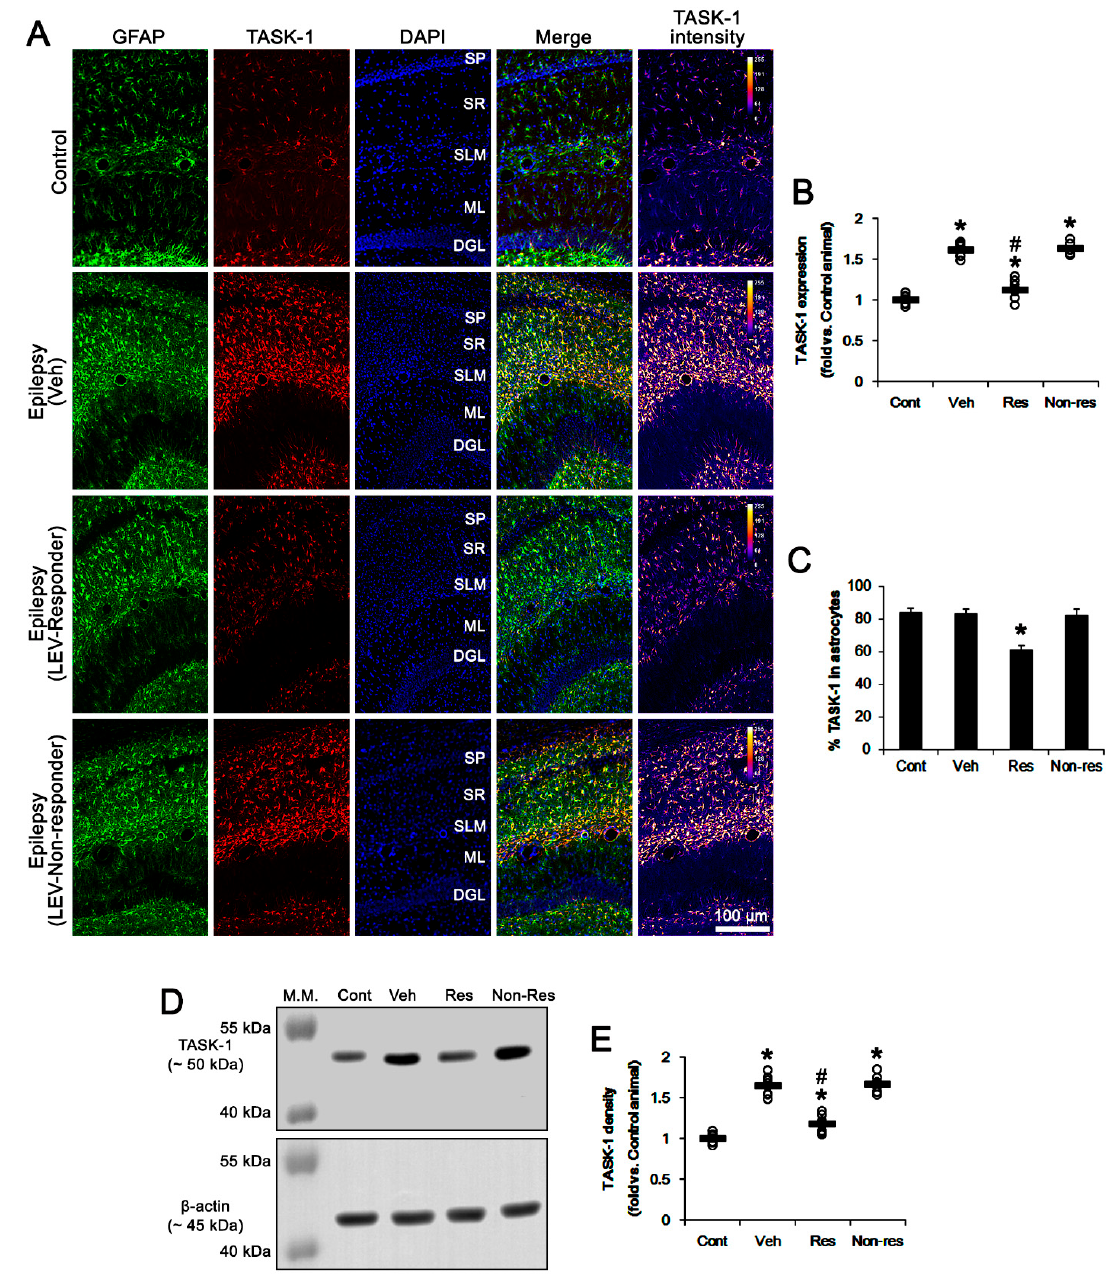
Figure 3. The effect of levetiracetam (LEV) on TASK-1 expression in chronically epileptic rats. As compared to control animals, TASK-1 expression is upregulated in CA1 astrocytes of epileptic rats. LEV significantly attenuated TASK-1 upregulation in responders, but not non-responders. ( A ) Representative photos of the TASK-1 expression in the hippocampus. SP, stratum pyramidale; SR, stratum radiatum; SLM, stratum lacunosum-moleculare; ML, molecular layer of the dentate gyrus; DGL, dentate granule cell layer. ( B ) Quantitative analyses of the effect of LEV on TASK-1 expression based on the immunohistochemical data ( *, #, p < 0.05 vs. the control and vehicle (Veh)-treated ani- mals, respectively; one-way ANOVA with post hoc Bonferroni’s multiple comparison, open circles indicate each individual value, horizontal bars indicate the mean value, error bars indicate the SEM). ( C ) Quantitative analyses on the effect of LEV on the fraction of TASK-1 positive astrocytes in total astrocytes ( * , p < 0.05 vs. control animals; one-way ANOVA with post hoc Bonferroni’s multiple